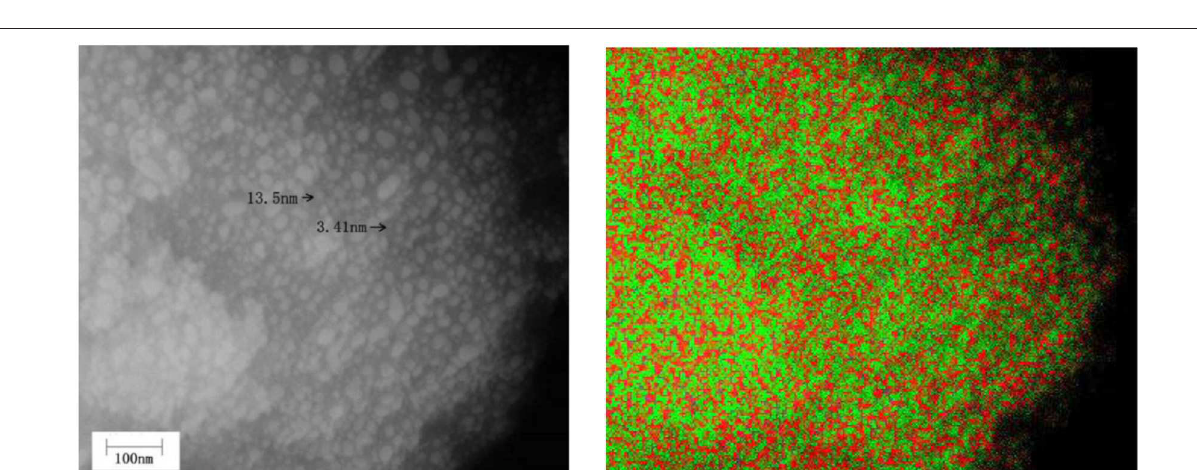
FIGURE 8 | SEM image of TiO 2 /montmorillonite composite (Com-700) (Left) and image of Si (red)–Ti (green) composition distribution in corresponding region (Right) .